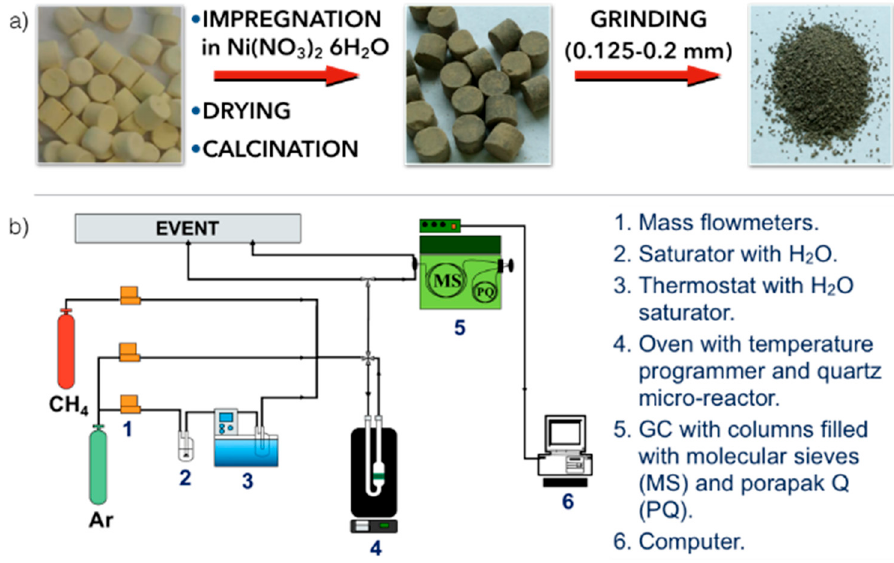
Figure 1. Scheme of ( a ) preparation of Ni/CeZrO 2 catalyst and ( b ) installation for catalytic